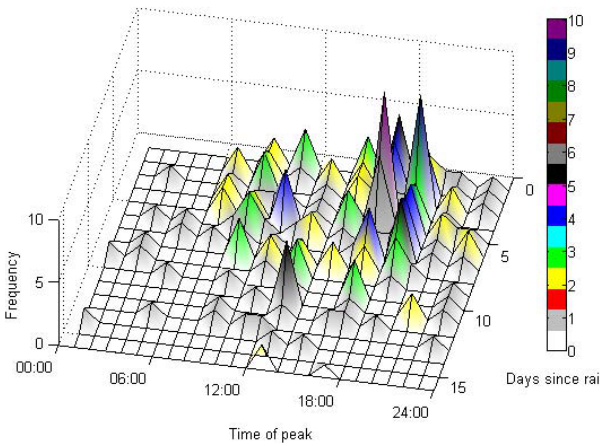
Fig. 7. Frequency map of peak time against the number of days since ≥ 1mm